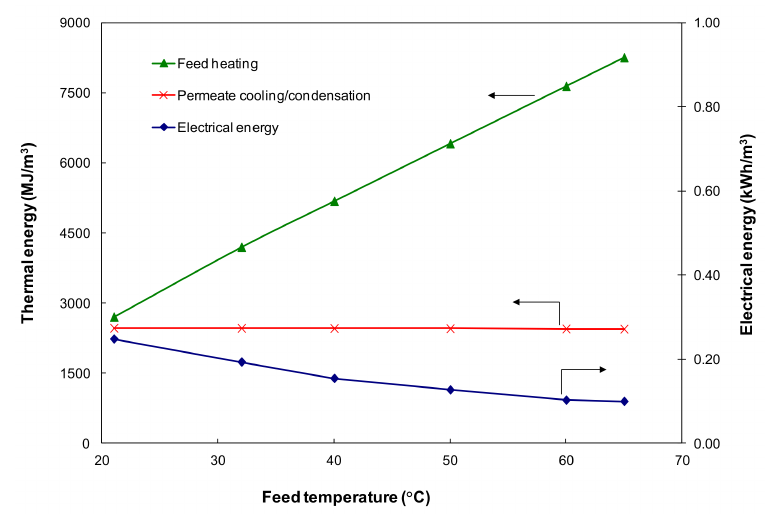
Figure 6. Effect of the feed temperature on thermal and electrical energy requirement (feed velocity 0.05 m/s, vacuum 6 Torr).